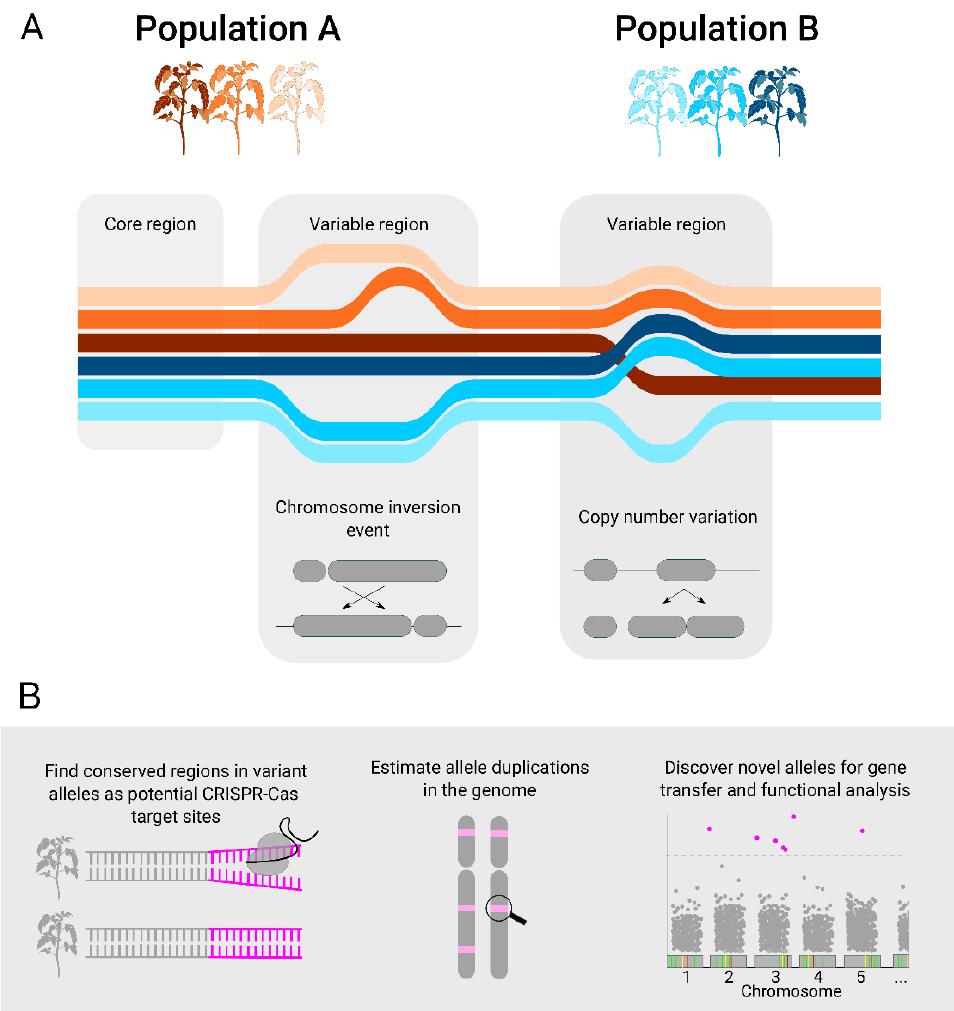
Figure 2. ( A ). Representation of a pangenome assembly composed of genomes from six individuals sourced from two populations. The core and variable regions of the pangenome are highlighted in this representation, in which the genetic diversity observed in the variable region can be caused by chromosome inversion or copy number variation (CNV). ( B ). Potential benefits of using pangenome reference for genetic modification, as the genetic diversity analysis can be used to define target sites in variant alleles, identify CNV that influence CRISPR-Cas mutation effectiveness and discover novel target alleles.